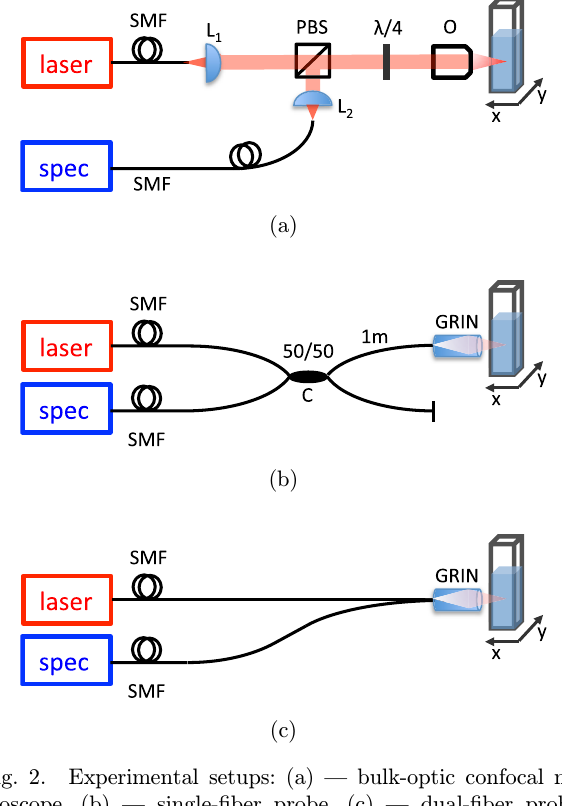
Fig. 2. Experimental setups: (a) — bulk-optic confocal mi- croscope, (b) — single-¯ber probe, (c) — dual-¯ber probe. (Key: spec — spectrometer, L 1 ,L 2 — aspherical lenses, O — microscope objective, PBS — polarization beam-splitter, SMF — single-mode ¯ber, (cid:1)= 4 — quarter-wave plate, GRIN